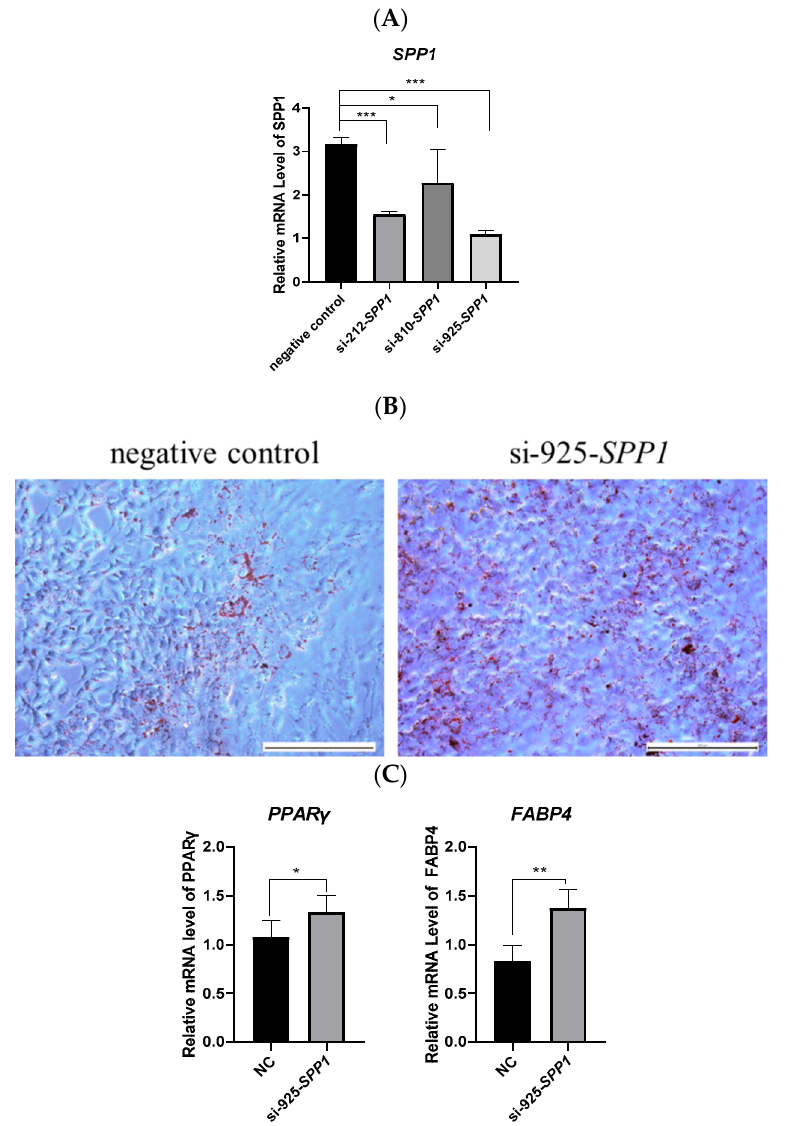
Figure 3. Inhibition of SPP1 promoted the adipogenic differentiation of pBMSCs. ( A ) pBMSCs were transfected with siRNA (si-212- SPP1 , si-810- SPP1 , and si-925- SPP1 ) or negative control, and to assay-interfering efficiency by expression of SPP1 two days after transfection. ( B ) Lipid droplet accumulation of pBMSCs transfected with si-925-SPP1 and negative control were verified by Oil Red O staining induction at 14 days (bar = 200 µ m). ( C ) The mRNA levels of PPAR γ and FABP4 in the si- 925-SPP1 group and the negative control group were confirmed by qRT-PCR. ***, p < 0.001; **, p < 0.01; *, p < 0.05.